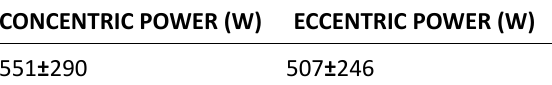
Table 1. Power values in isoinersial resistance